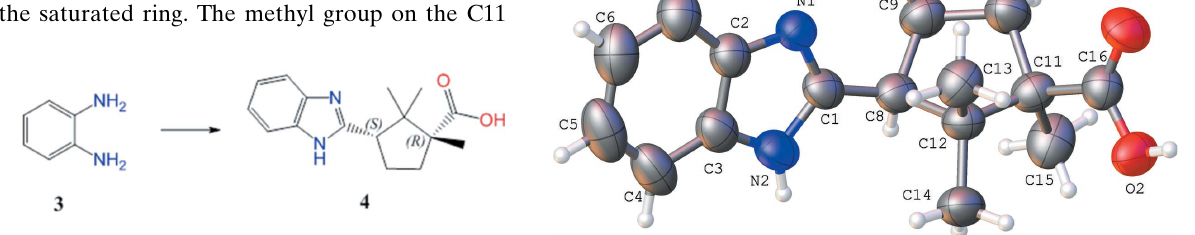
Figure 3 The molecular structure of the title compound 4 with the atom labeling. Displacement ellipsoids are drawn at the 50% probability level.